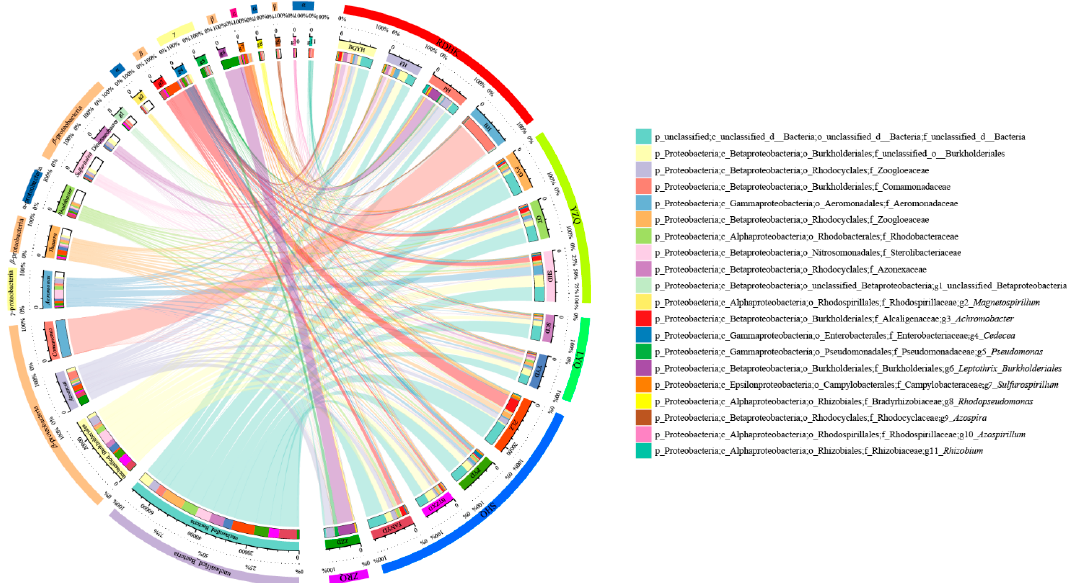
Figure 4. Distribution of aerobic denitrifying microbial community for each sample in the Baiyangdian Lake. (The width of the bars from each taxonomy indicate the relative abundance of that taxonomy in the sample).